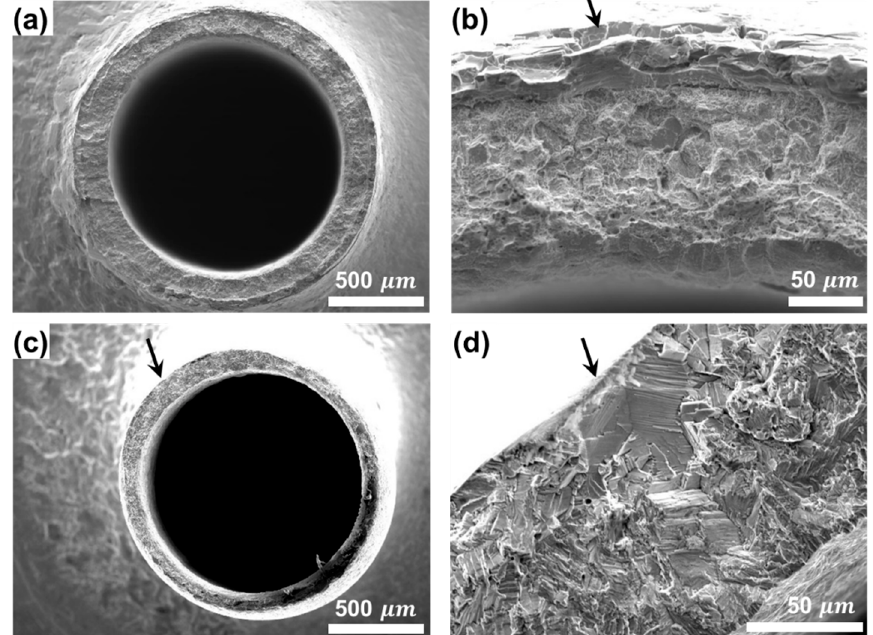
Figure 9. Fracture surfaces for ( a , b ) short-life (444,361 cycles) and ( c , d ) long-life (2,891,024 cycles) specimens tested at RT and σ max = 495 MPa.